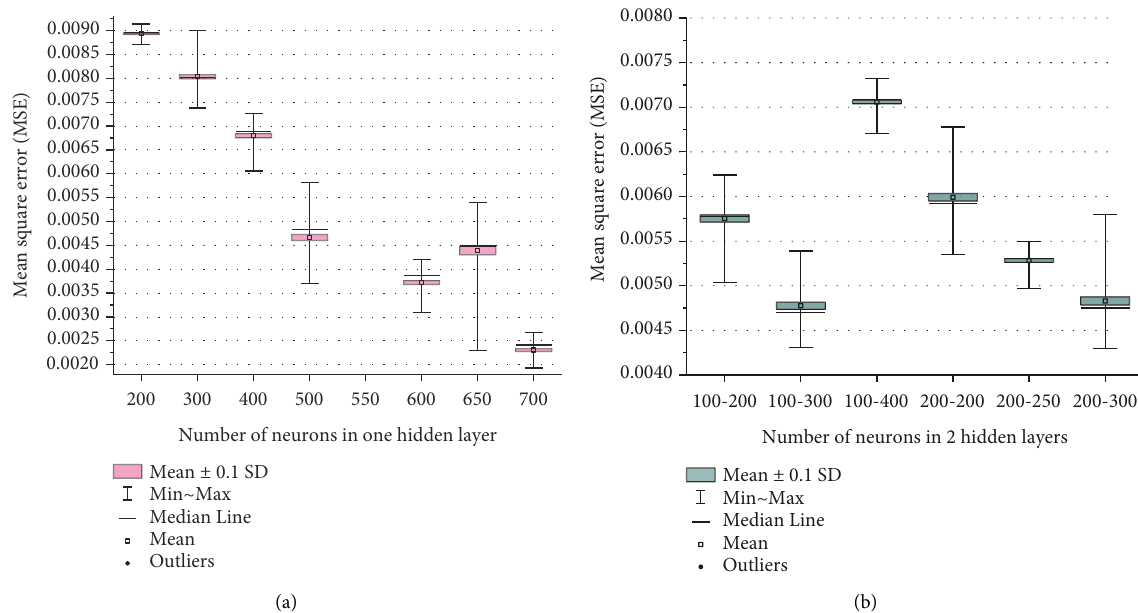
Figure 8: Regression loss evaluation from 3 individual shape experiments on number of neurons in one hidden layer (a) two hidden layers, and (b) ANN models.